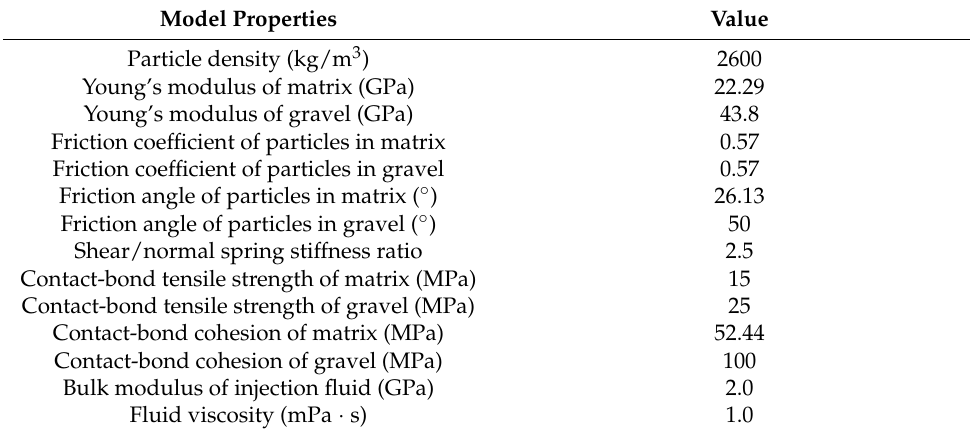
Table 1. Simulation parameters.